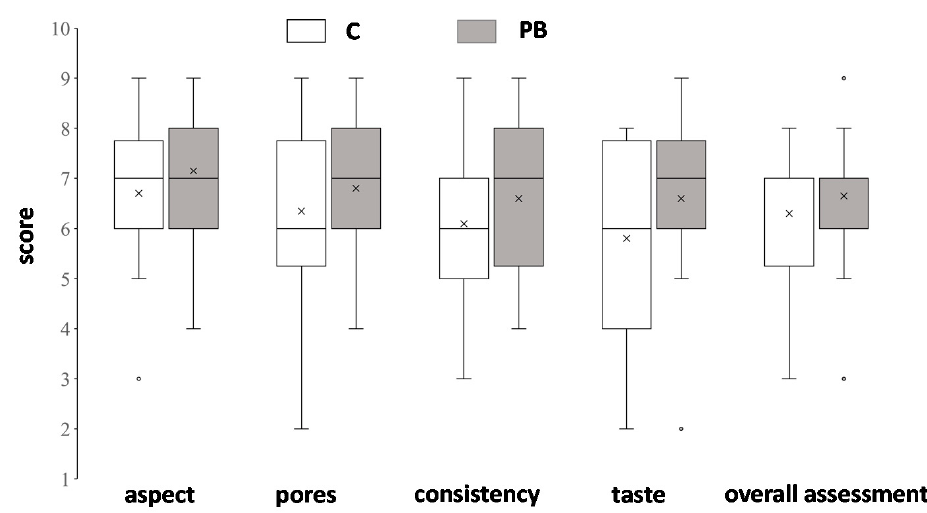
Figure 5. Box plot for sensorial analysis C and PB